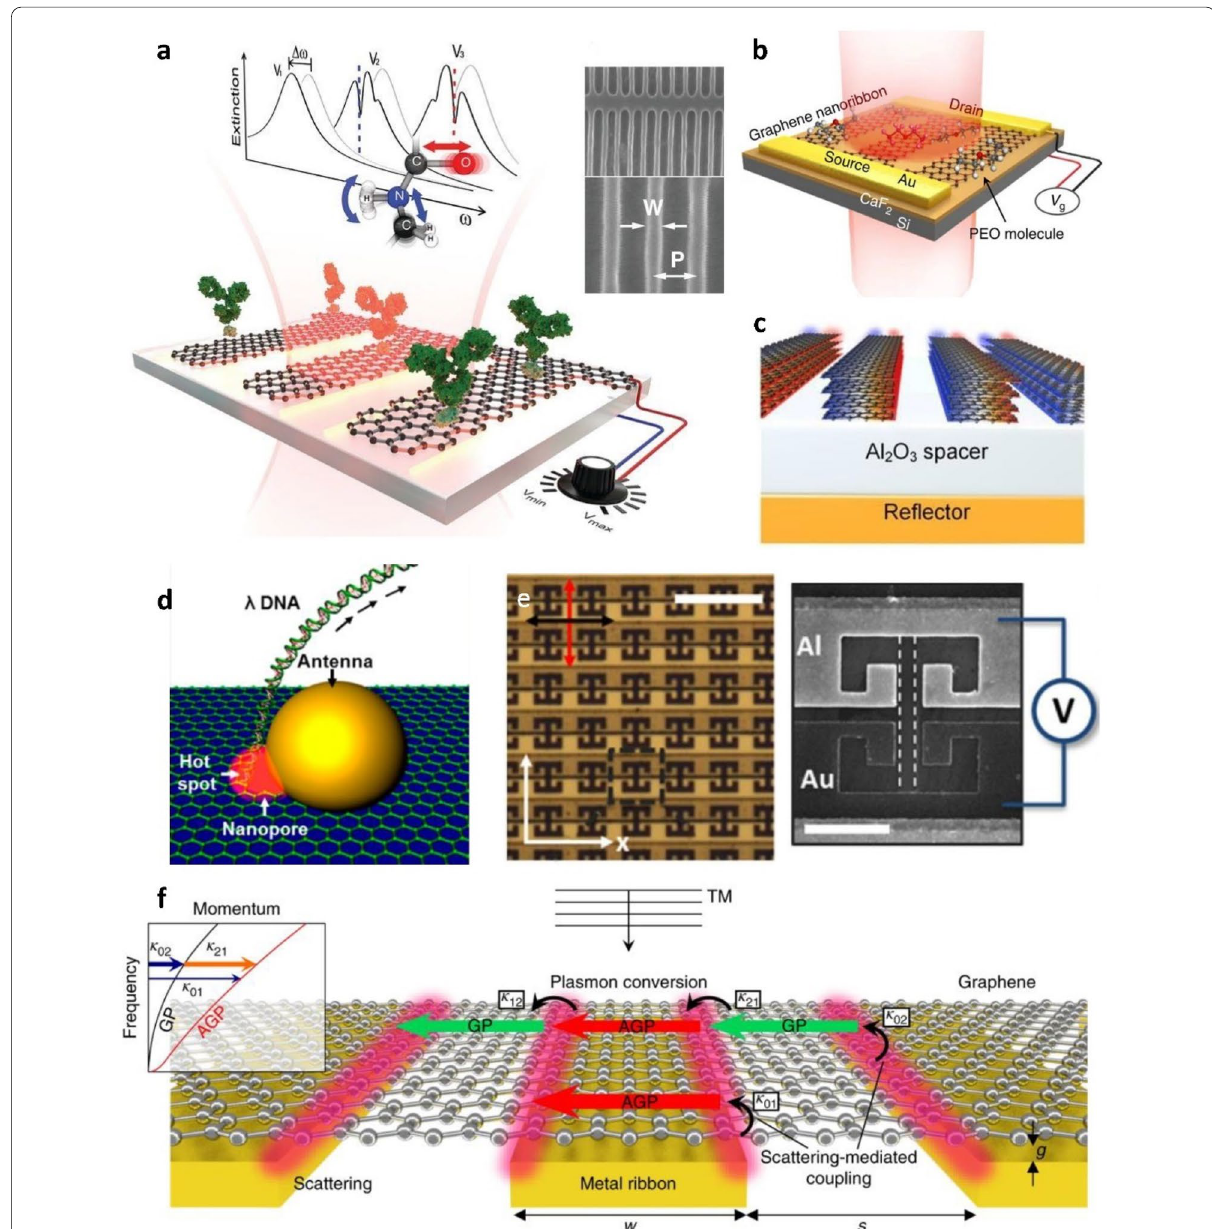
Fig. 7 Graphene-based plasmonic sensors for biosensing. a Graphene plasmonic biosensor for protein. The proteins adsorbed on the graphene surface were detected by resonance frequency shift accompanied by dips of protein vibration bands. From [7]. Reproduced with